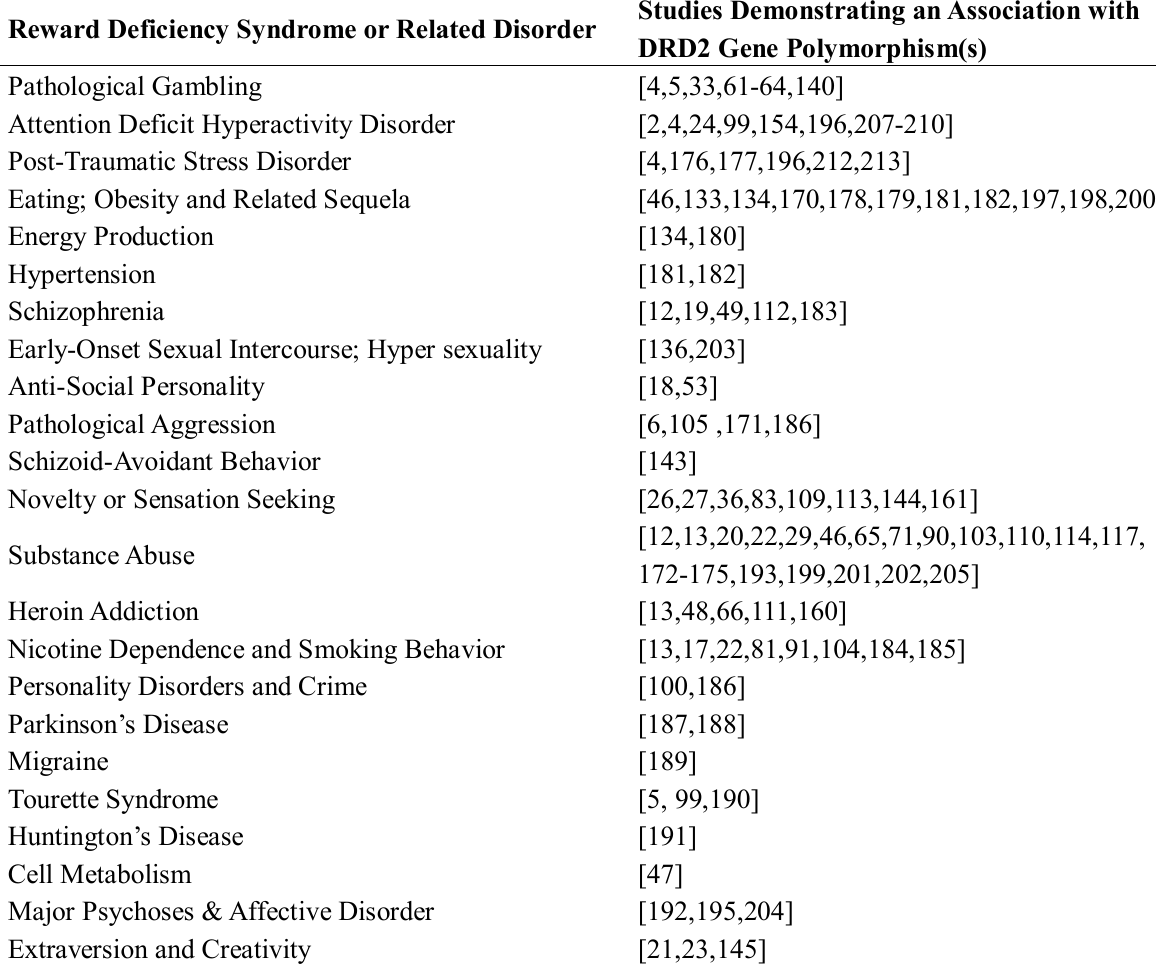
Table 3. Correlation of RDS and related neurological and psychiatric disorders with DRD2 SNP (a